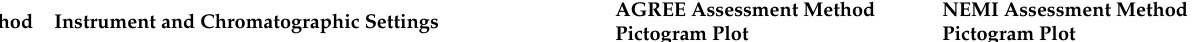
Method Instrument and Chromatographic